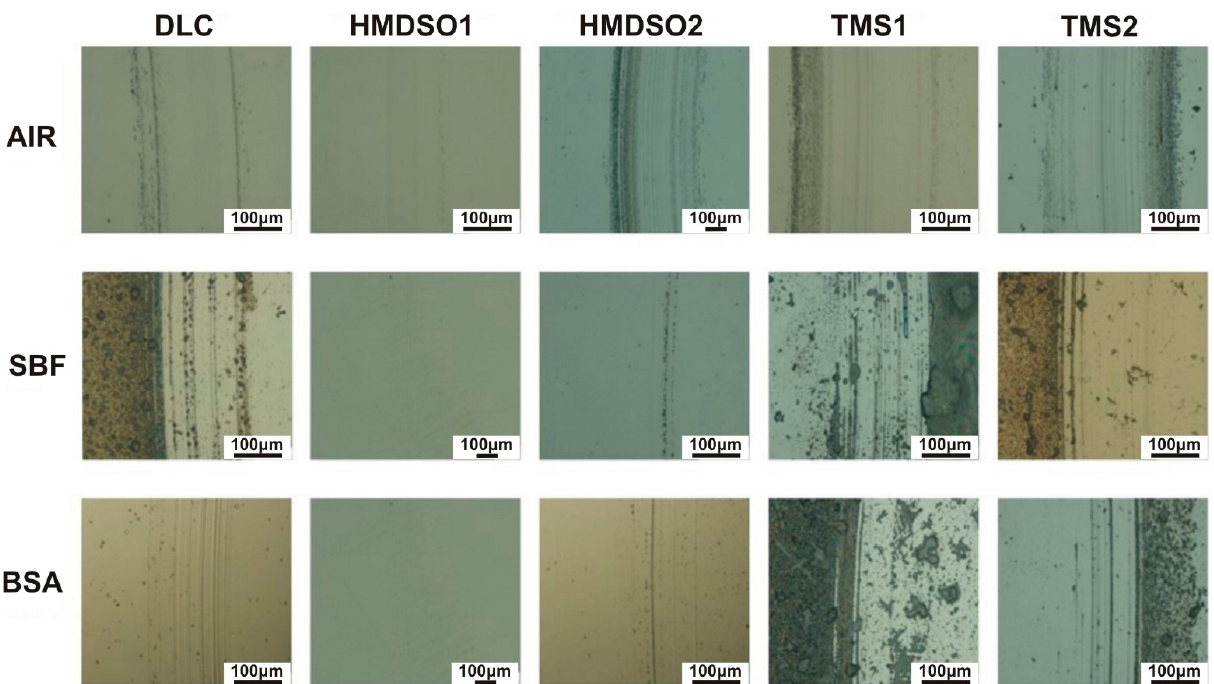
Figure 3. Wear tracks on the surface of DLC and silicon-incorporated DLC coatings tested in different environments. The scale bar length on all images is equal to 100 µm.